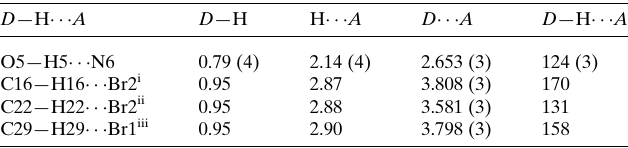
Table 1 Hydrogen-bond geometry (A˚ , (cid:4) ).